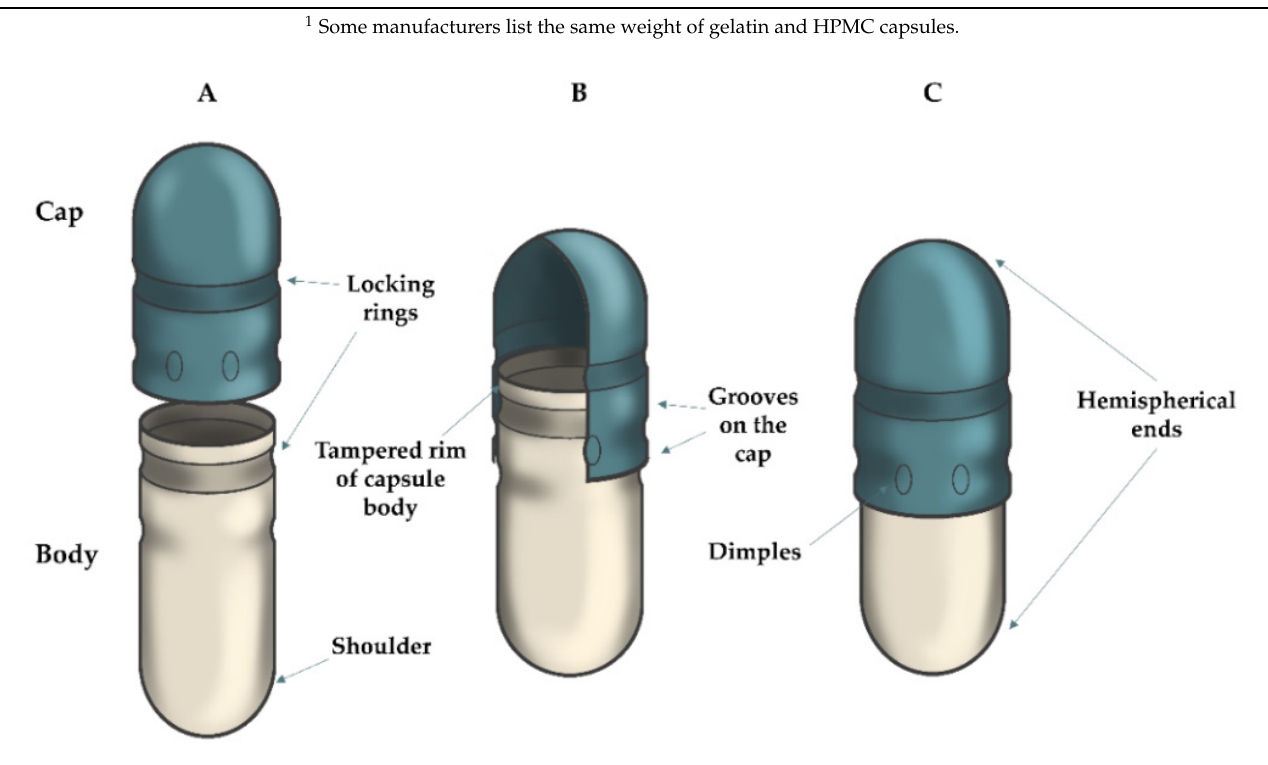
Figure 1. Structure of the common type of enteric hard capsule prepared with ECDDT (Snap-fit type): ( A ) open position with two capsule parts (cap, body); ( B ) pre-closed position; ( C ) closed position of hard capsule.